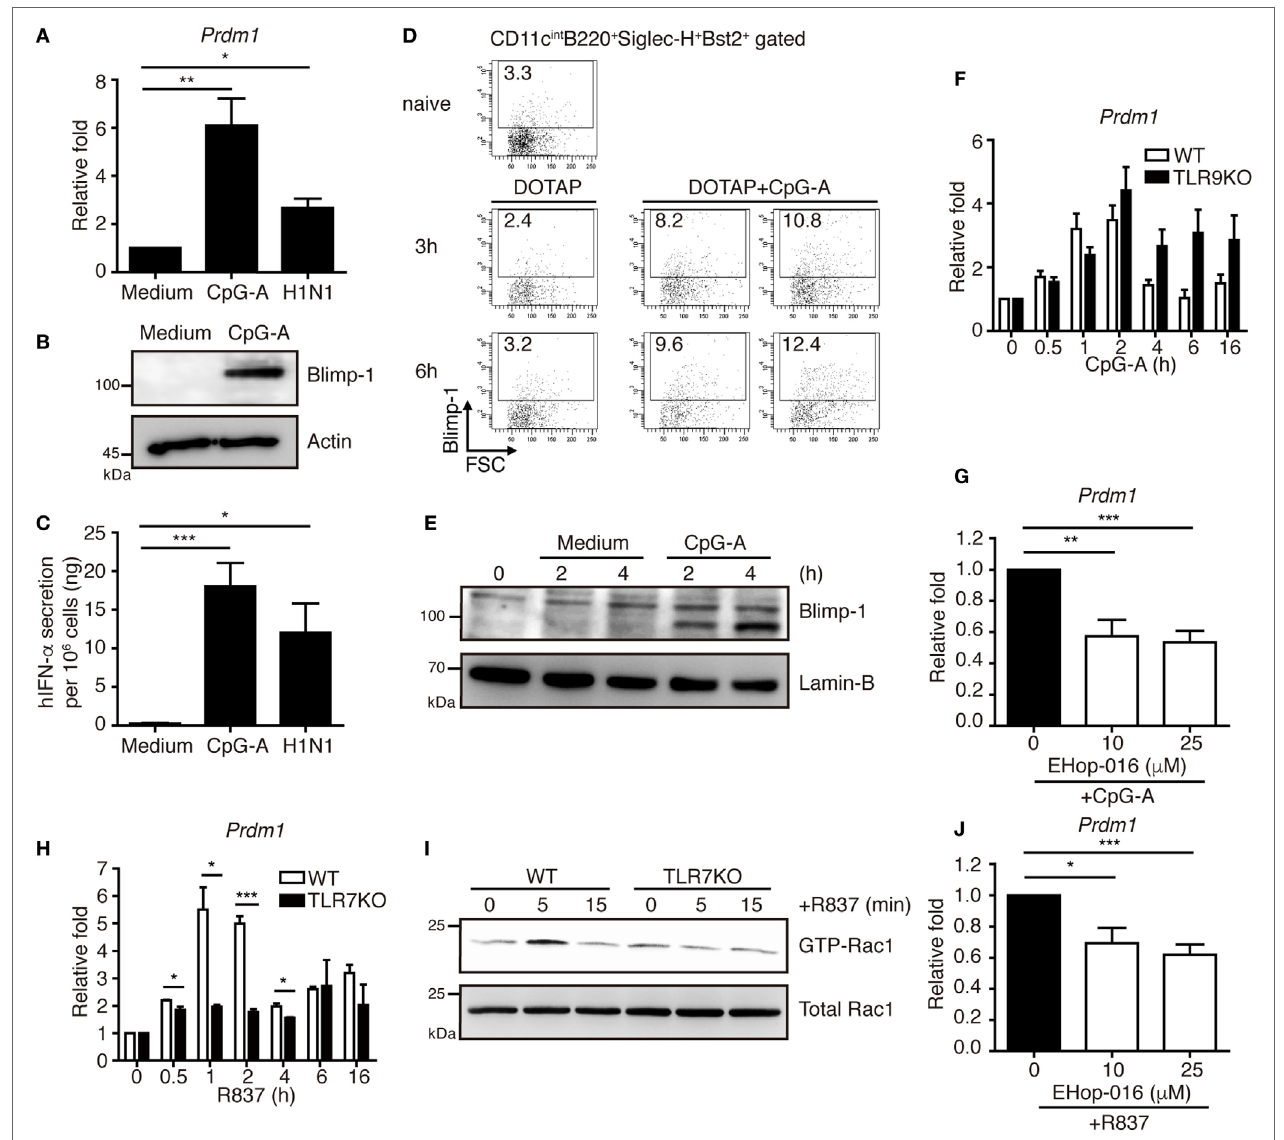
FigUre 1 | Blimp-1 was induced via Rac activation after TLR7/9 ligand treatment in plasmacytoid dendritic cells (pDCs). (a) RT-quantitative PCR (RT-qPCR) showing Blimp-1 mRNA in human pDCs 24 h after treatment with medium alone, 1 µM CpG-A and H1N1 at a titer of 10 4 TCID50/ml. (B) Blimp-1 protein levels were determined by immunoblotting in human pDCs 24 h after treatment with medium alone or 1 µM CpG-A. (c) ELISA showing the levels of IFN- α produced by human pDCs as described in (a) . (D) Blimp-1-yellow fluorescent protein reporter mice were intravenously injected with DOTAP alone or DOTAP + CpG-A. The frequency of Blimp-1 + pDCs in splenic CD11c int B220 + Siglec-H + Bst2 + gate was examined at indicated time after infection. The frequency of Blimp-1 + pDCs from untreated group (naïve) was shown for comparison. (e) Nuclear Blimp-1 protein levels were detected by immunoblotting in mouse FLpDCs stimulated with medium alone or 1 µM CpG-A at indicated time points. Freshly isolated FLpDCs at 0 h, before addition of medium alone or CpG-A, were also used as the control. (F) RT-qPCR showing the Blimp-1 mRNA levels in Tlr9 knockout (KO) FLpDCs treated with 1 µM CpG-A. (g) RT-qPCR showing Blimp-1 mRNA levels in FLpDCs after 1 h pre-treatment with EHop-016 and further treatment with 1 µM CpG-A for 1 h. (h) RT-qPCR showing the Blimp-1 mRNA levels in Tlr7 KO FLpDCs treated with 2 µg/ml R837 for 1 h. (i) Rac1 activation determined by PAK1 PBD agarose beads pulled down and immunoblotting with antibody against Rac1 in FLpDCs from WT and TLR7 KO mice after stimulation with 2 µg/ml R837. (J) RT-qPCR showing Blimp-1 mRNA expression in FLpDCs after 1 h pre-treatment with EHop-016 and further treatment with 2 µg/ml R837 for 1 h. Data represent the mean ± SEM and were analyzed by two-tailed unpaired Student’s t -test [ n = 3 − 6 in (a) , 4 − 7 in (c) , 3 in (F) , 5 − 6 in (g) , 3 in (h) , and 4 − 5 in (J) ]. * p < 0.05; ** p < 0.01; *** p <